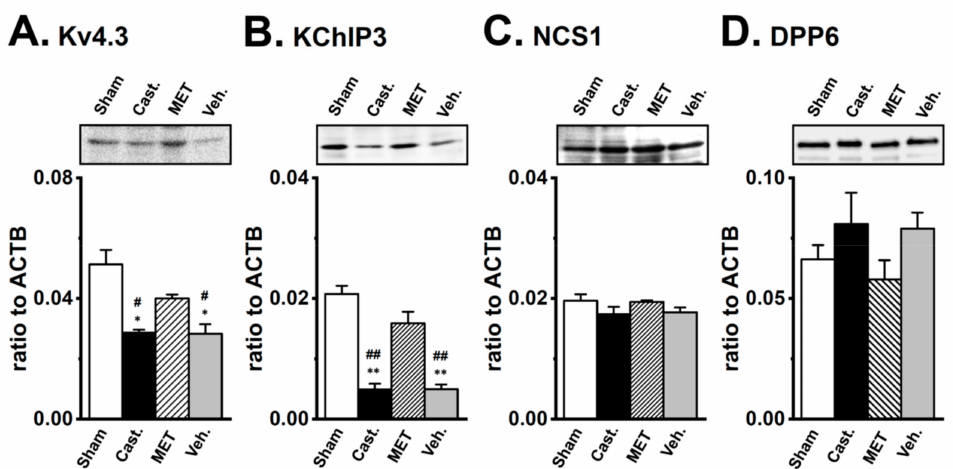
Figure 6. Changes in the protein expression of Kv4 α and Kv4 β by castration in rat VDSMs. The expression of the Kv4.3, KChIP3, NCS1, and DPP6 proteins in vas deferens of each group was examined by Western blotting. The membrane fraction extracted from the VDSMs of each group was immunoblotted with the anti-Kv4.3 (1:200), anti-KChIP3 (1:200), anti-NCS1 (1:200), and anti-DPP6 (1:500) antibodies. Values were expressed as a ratio to those in the VDSMs of sham-operated rats. ( A ) Kv4.3, ( B) KChIP3, ( C ) NCS1, and ( D ) DPP6 ( n = 4 for each). Open columns—Sham, black columns—Cast., hatched columns—MET, and gray columns—Veh. *, ** p < 0.05, 0.01 versus sham-operated; # , ## p < 0.05, 0.01 versus